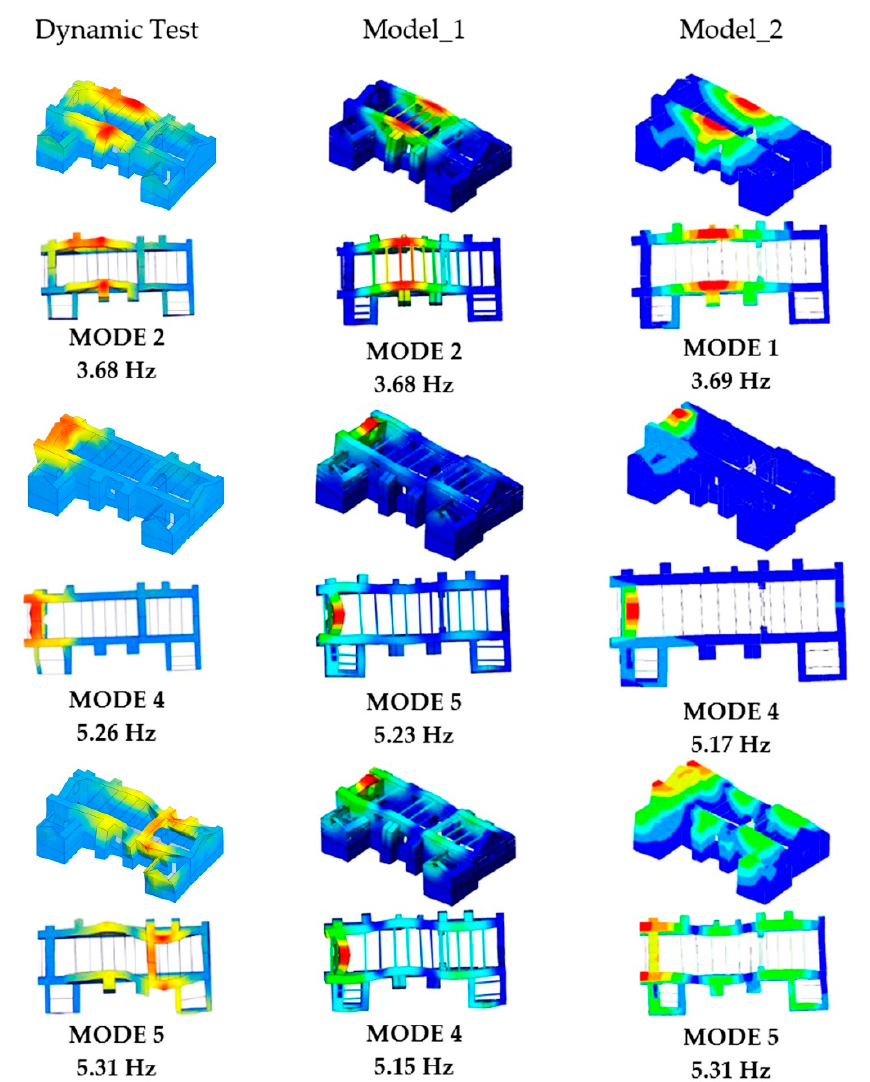
Figure 17. Mode shapes of the selected modes in MODEL_1 and MODEL_2, as obtained from the updated numerical models, in comparison with the modal shapes of the dynamic tests, for the retrofitted church. Table 7. MAC values for MODEL_1 and AVT.